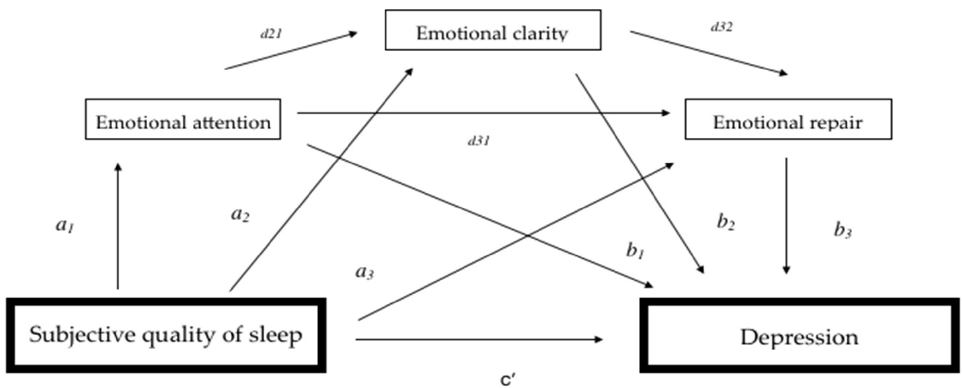
Figure 1. Conceptual and statistical diagram of the serial mediation of Emotional Intelligence in subjective sleep quality and depression.